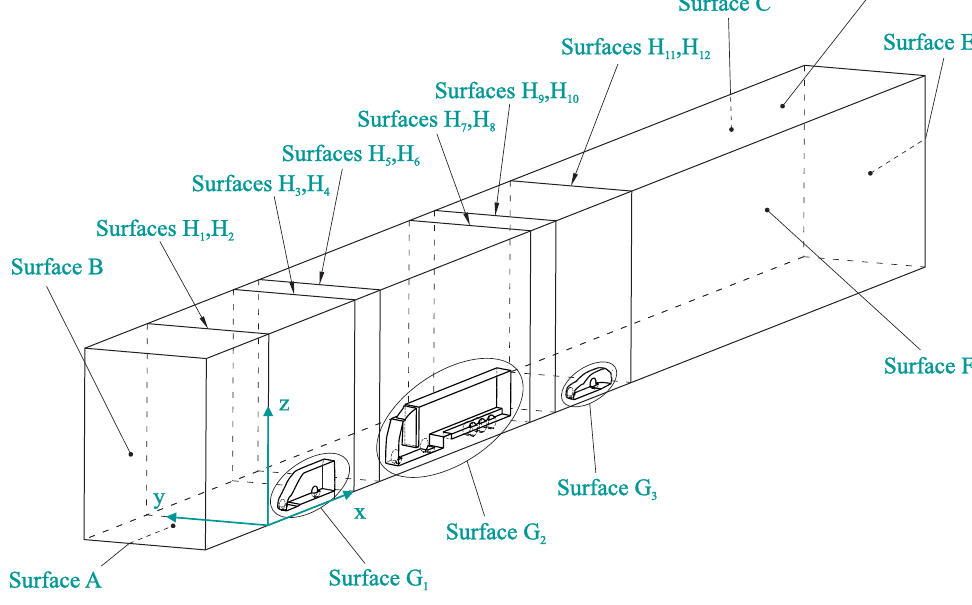
Figure 7. Surface description for boundary conditions on the example of van–truck–car platoon with spacing of 8